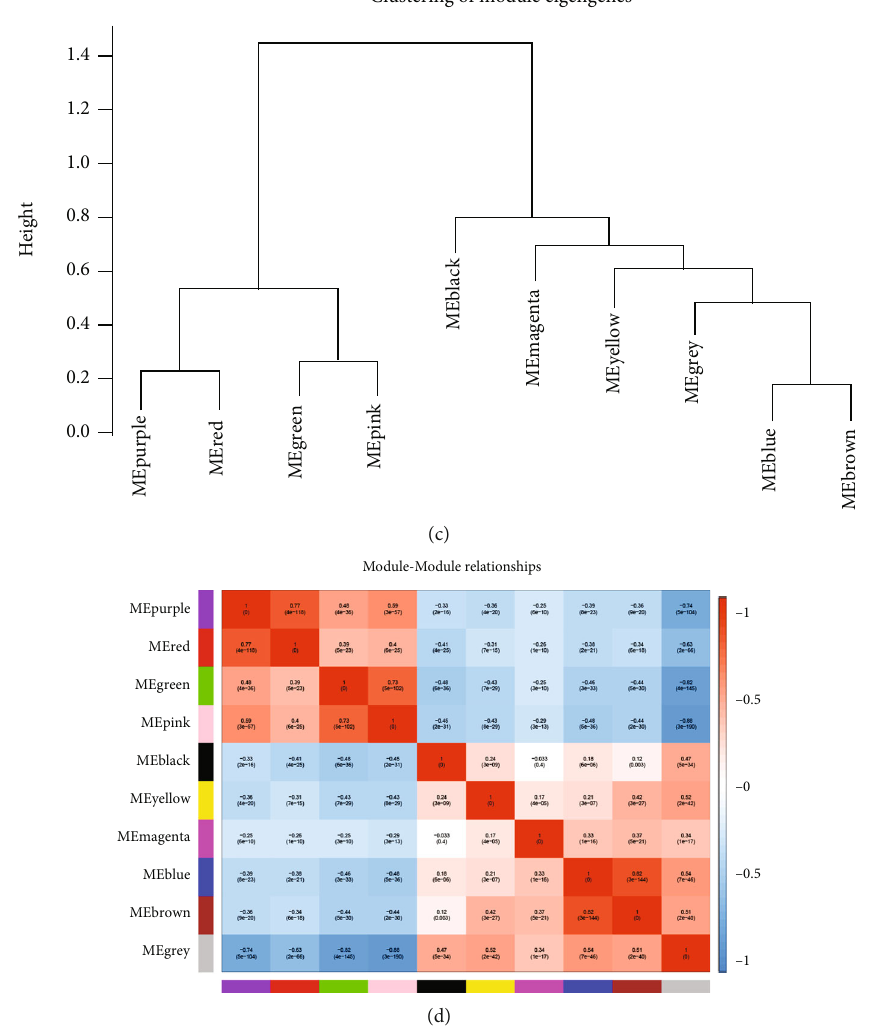
Figure 2: DEGs were analyzed using the WGCNA and gene clustering tree analyses of module eigengenes. (a) Scale-free exponential analysis of various soft threshold powers ( β ). (b) Clustered module dendrogram (top) and colored bands (bottom) of DEGs, and each dendrogram represents module color. (c) Gene cluster dendrogram based on dissimilarity of topological overlap and module color assignment. (d) Correlation analysis of modules. ME: module